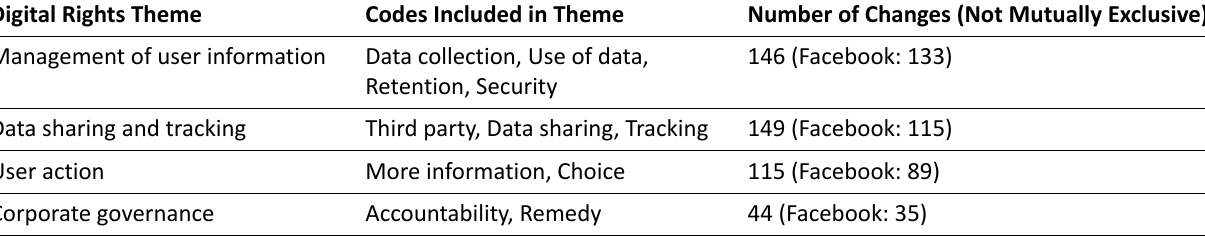
Table 3. Digital rights themes and